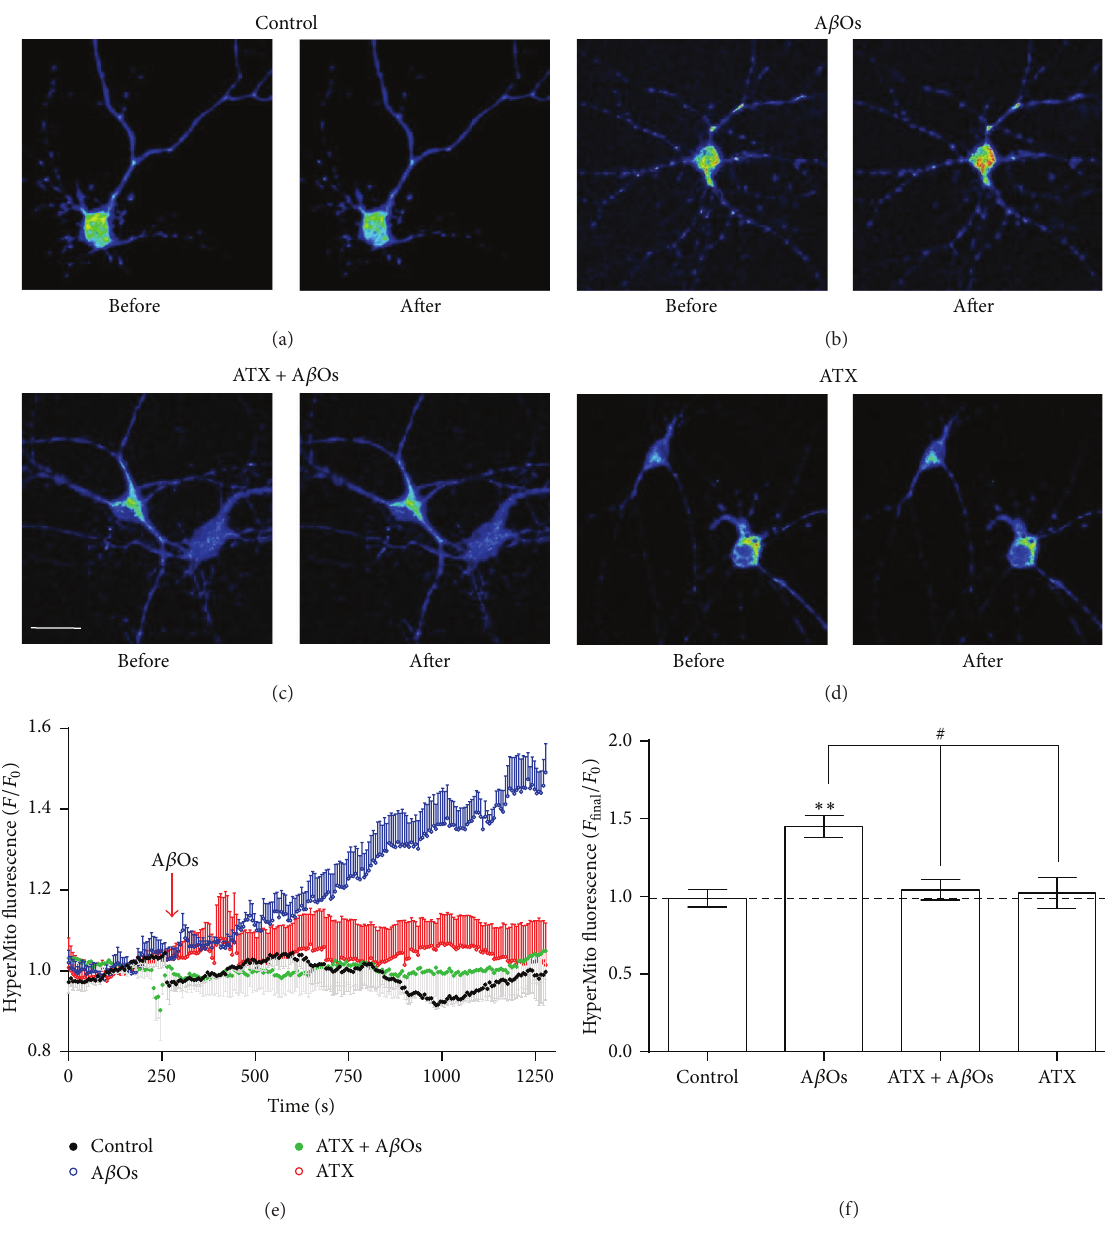
Figure 2: ATX prevents mitochondrial H 2 O 2 generation induced by A 𝛽 Os. Hippocampal neurons (13–15DIV) were transfected with HyperMito, 24h before the experimental maneuvers. ((a)–(d)) show representative pseudocolor images of hippocampal neurons expressing the HyperMito protein, collected before (250 s, left images) or 1000 s after (1250s, right images) the addition of vehicle ((a) and (d)) or of 500 nM A 𝛽 Os ((b) and (c)). Higher fluorescence intensity levels are expressed by the red color in a pseudocolor scale, while lower intensity levels are expressed by blue color. Scale bar: 10 𝜇 m. (e) shows representative time courses of HyperMito fluorescence, recorded in neuronal soma after the addition of vehicle (black symbols) or 500 nM A 𝛽 Os in the absence (blue symbols) or presence (green symbols) of 0.1 𝜇 M ATX preincubated for 1.5h, which alone did not induce changes in HyperMito fluorescence (red symbols). Fluorescence changes (mean ± SE) are expressed as ( 𝐹/𝐹 0 ), where 𝐹 0 corresponds to the basal fluorescence recorded in the soma before A 𝛽 Os addition. The graph illustrates average values from 2 ROIs registered at the soma of neurons recorded in the visual field ( 𝑛 = 4 ). Values correspond to four different experiments performed in four cultures from four different animals; each condition was tested in duplicate. (f) shows the values of 𝐹/𝐹 0 obtained at the end of the experiment (time 1250s) to each condition and bars represent mean ± SE. Statistically significant differences among experimental conditions were evaluated by one-way ANOVA followed by Bonferroni’s multiple comparison test ( ∗∗ 𝑝 < 0.001 compared to control; # 𝑝 < 0.05 compared to indicated